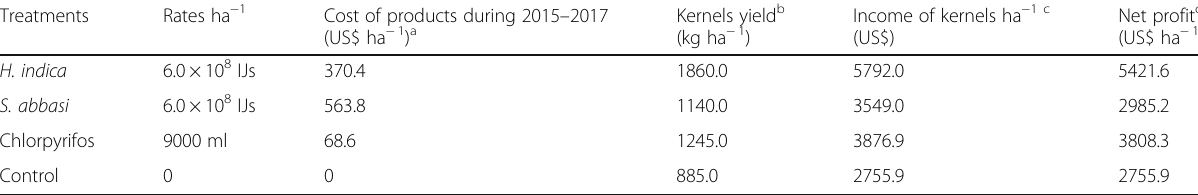
Table 1 Cost and benefit for the control of third-instar larvae of Leucopholis lepidophora with Heterorhabditis indica , Steinernema abbasi , and chlorpyrifos in the areca nut field